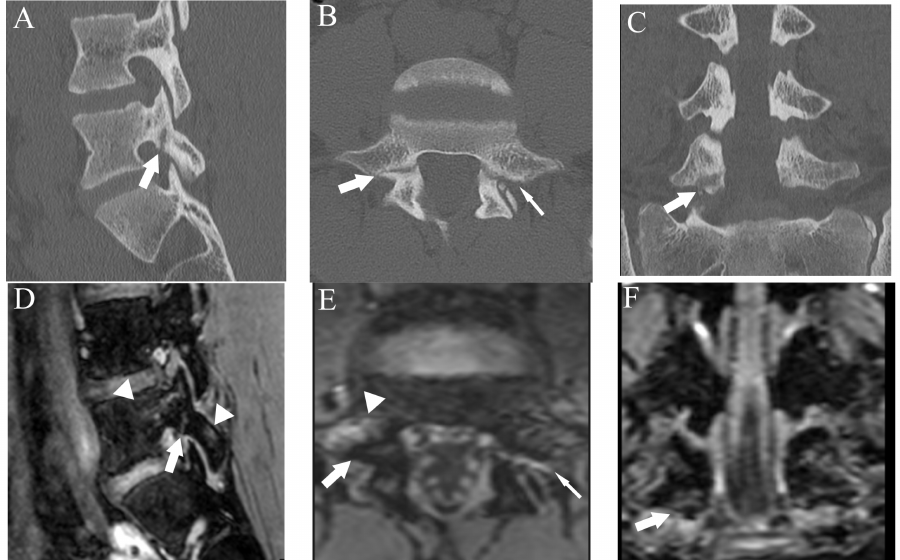
Figure 6. Comparison of grade 2 fracture at the right pars interarticularis at L5 from a 14-year-old male in multiple planes between CT and DESS. ( A – C ) CT shows grade 2 fracture on the right pars interarticularis on the right-sided sagittal, axial, and coronal plane, respectively (arrows). On the axial plane, fracture of the left side is also delineated (thin arrow). ( D – F ) DESS shows grade 2 fractures comparable to CT on the right-sided sagittal, axial, and coronal plane, respectively (arrows). The sagittal and axial images delineate BME around the fracture (arrowhead), and the left pars interarticularis fracture is also delineated on the axial image (thin